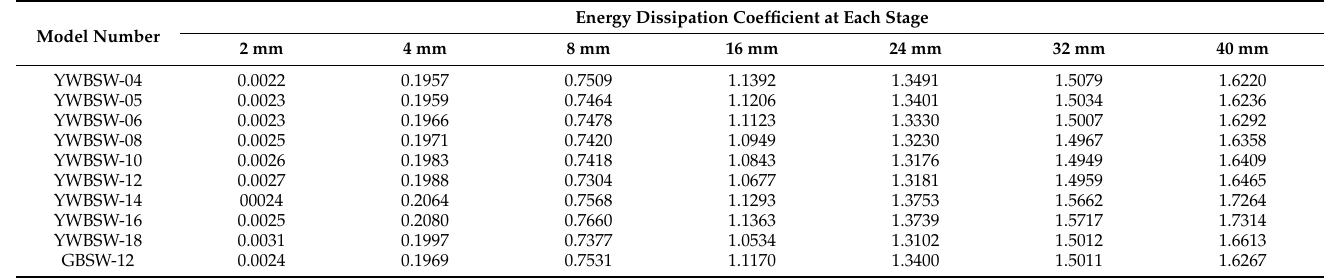
Table 6. Energy dissipation coefficient for models with different fishplate thicknesses.